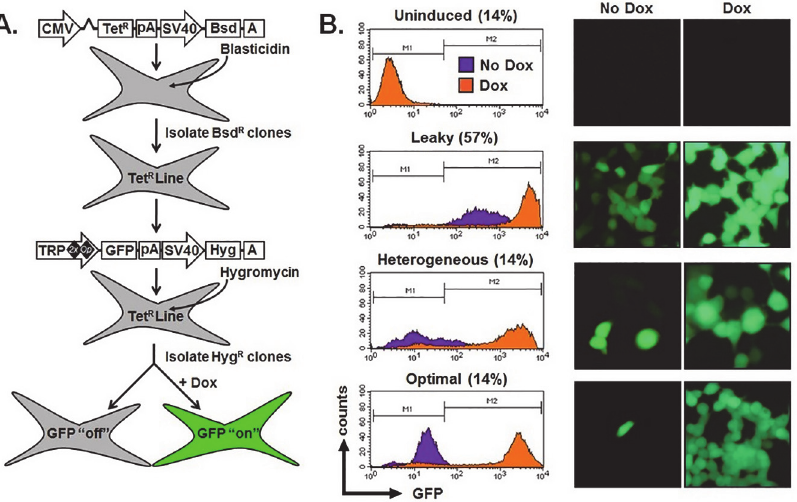
Fig 1. Failure to consistently generate clonal cell populations with an “ off/on ” phenotype using a commercially available tetracycline inducible expression system. (A) Schematic diagram of the plasmids and methodology used to create blasticidin-resistant (Bsd R ) cell lines with stable expression of the tetracycline-repressor (Tet R ) protein. These cells were further modified for coexpression of a hygromycin- resistance gene (Hyg R ) and enhanced green fluorescent protein (GFP) that is repressed “ off ” but can become transcriptionally active “ on ” upon administration of doxycycline (Dox). (B) Flow cytometry histograms (left) and fluorescent microscopy images (right, original magnification 40x) demonstrating expression of GFP in cell lines cultured in the absence (purple, No Dox) and presence of 4 μ M doxycycline (orange; Dox). Shown are representative examples of clones that were not inducible (Uninduced), were not adequately repressed (Leaky), were only partially induced (Heterogenous), or considered to be optimally repressed and induced (Optimal). The percentage of clones for each category are indicated (n = 21 cell lines). CMV, cytomegalovirus; Tet R , tet-repressor protein; TRP, tet-responsive promoter; Bsd, blasticidin resistance gene; Hyg, hygromycin resistance gene; GFP, green fluorescent protein; pA, poly adenylation signal; A, poly adenylation signal.